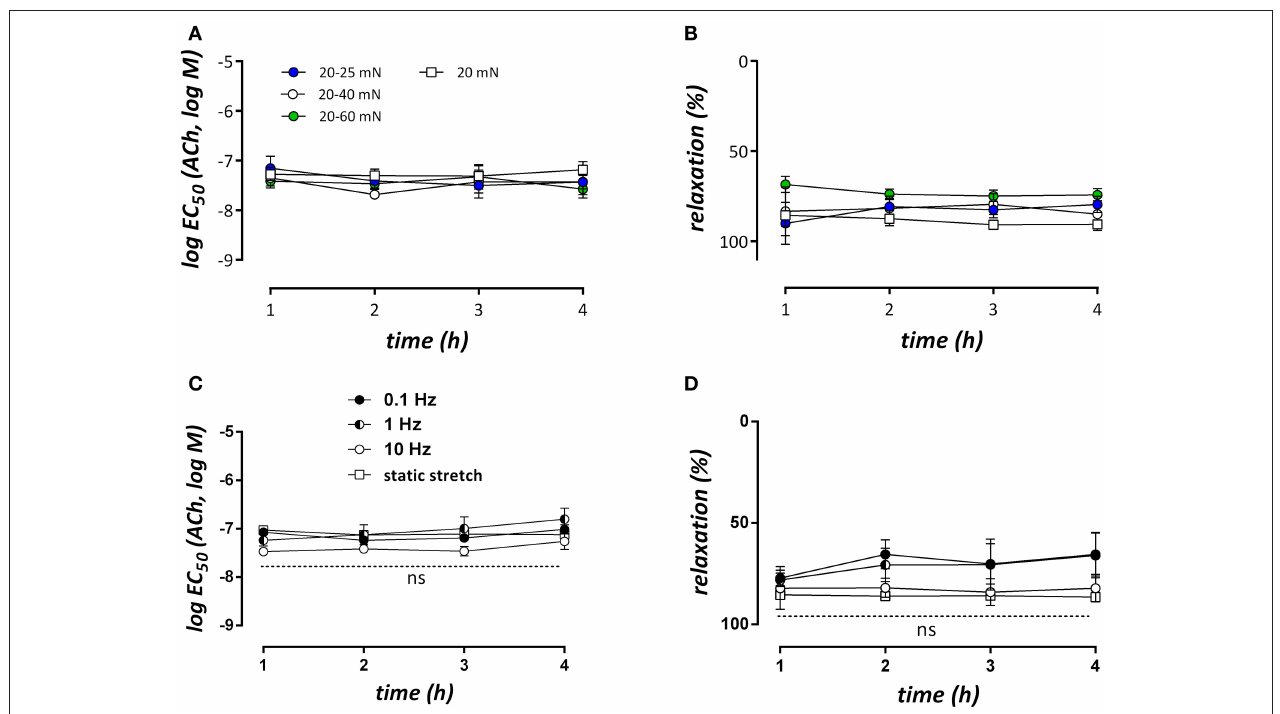
FIGURE 8 | LogEC 50 - and E max -values for ACh-mediated relaxations of contractions induced by 2 µ M PE at different time intervals after mounting the segments ( n = 5, each). In (A,B) segments were conditioned at 10Hz and different stretch amplitudes (no cyclic stretch, 20–25, 20–40, and 20–60 mN), whereas in (C,D) the stretch amplitude was 20mN (20–40 mN), but the frequency was 10, 1, or 0.1Hz. All contractions and relaxations were measured in isometric conditions at 20 mN. n = 5–6, two-way ANOVA with Tukey’s multiple comparison